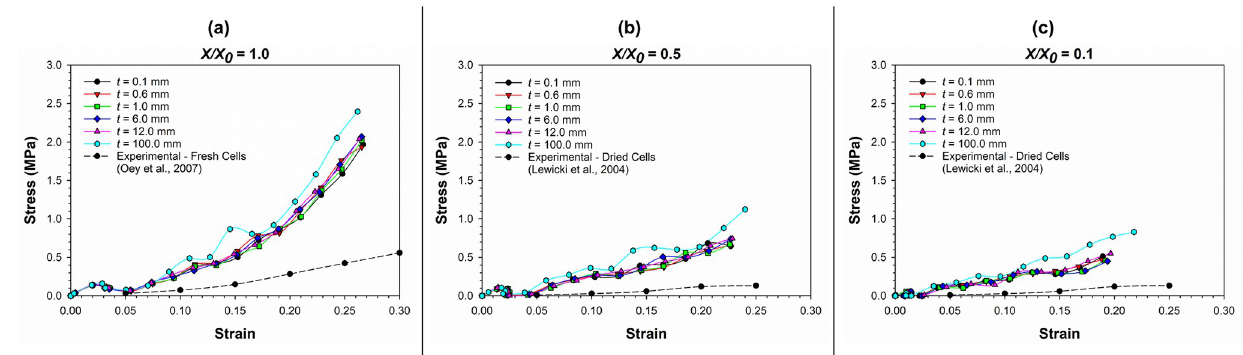
Fig 16. The stress-strain relationship of cells as affected by different cell wall thickness ( t ) values. (a) fresh cells ( X/X ( X/X 0 = 0.5); (c) extremely dried cells ( X/X 0 = 0.1) ( X/X 0 is the normalised moisture